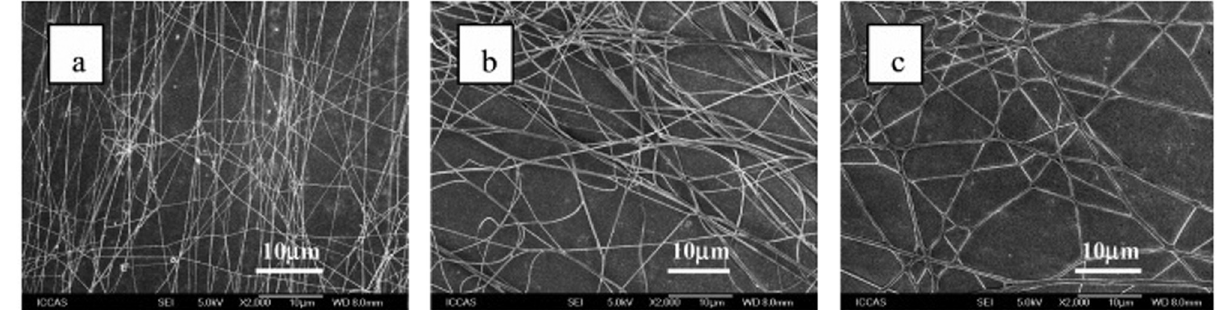
Figure 9: Scanning electron microscopic images of SA fi bers electrospun from SA solution with di ff erent concentrations: ( a ) 1.6, ( b ) 2.0, and ( c ) 2.4 w/v%. The volume ratio of glycerol to water was constant ( 2/1 ) . Image reprinted with permission from [ 107 ] . Copyright: 2008 American Chemical